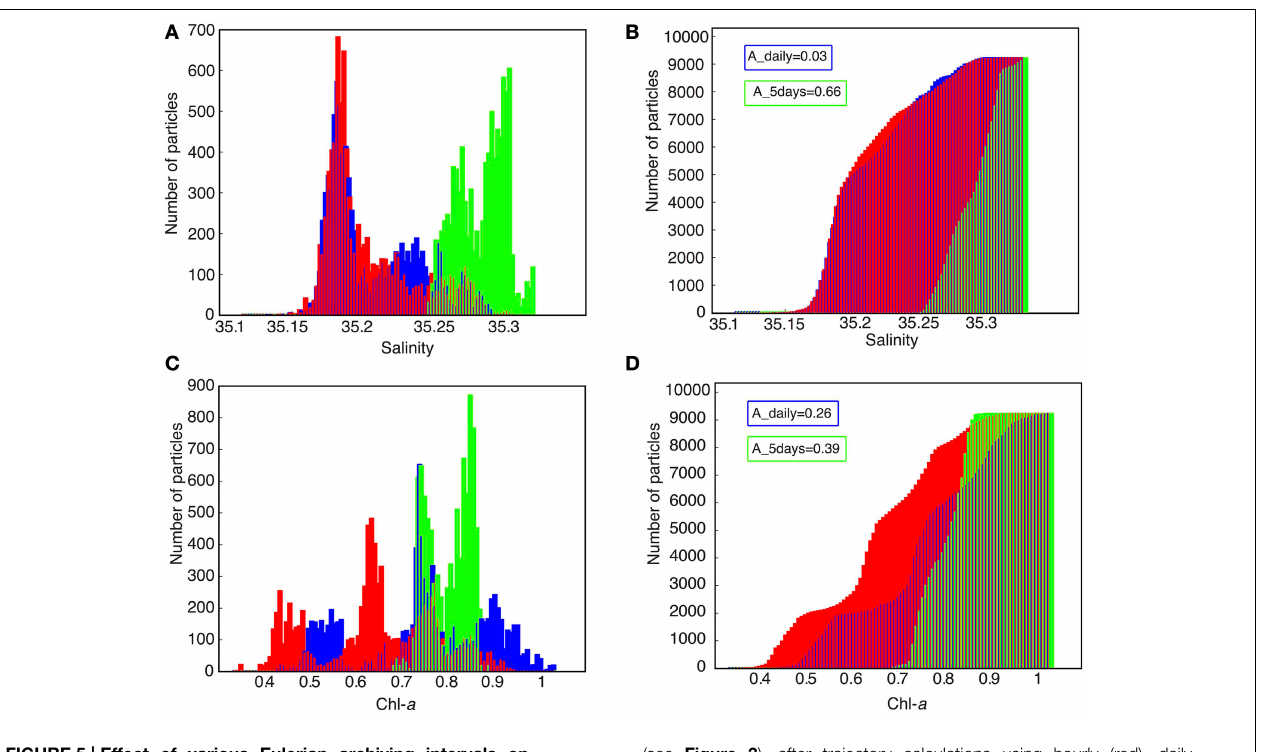
FIGURE 5 | Effect of various Eulerian archiving intervals on Lagrangian qualitative experiments. Histograms (A–C) and cumulative histograms (B–D) of some properties of the particles initialized in the immediate neighborhood of the reference particle